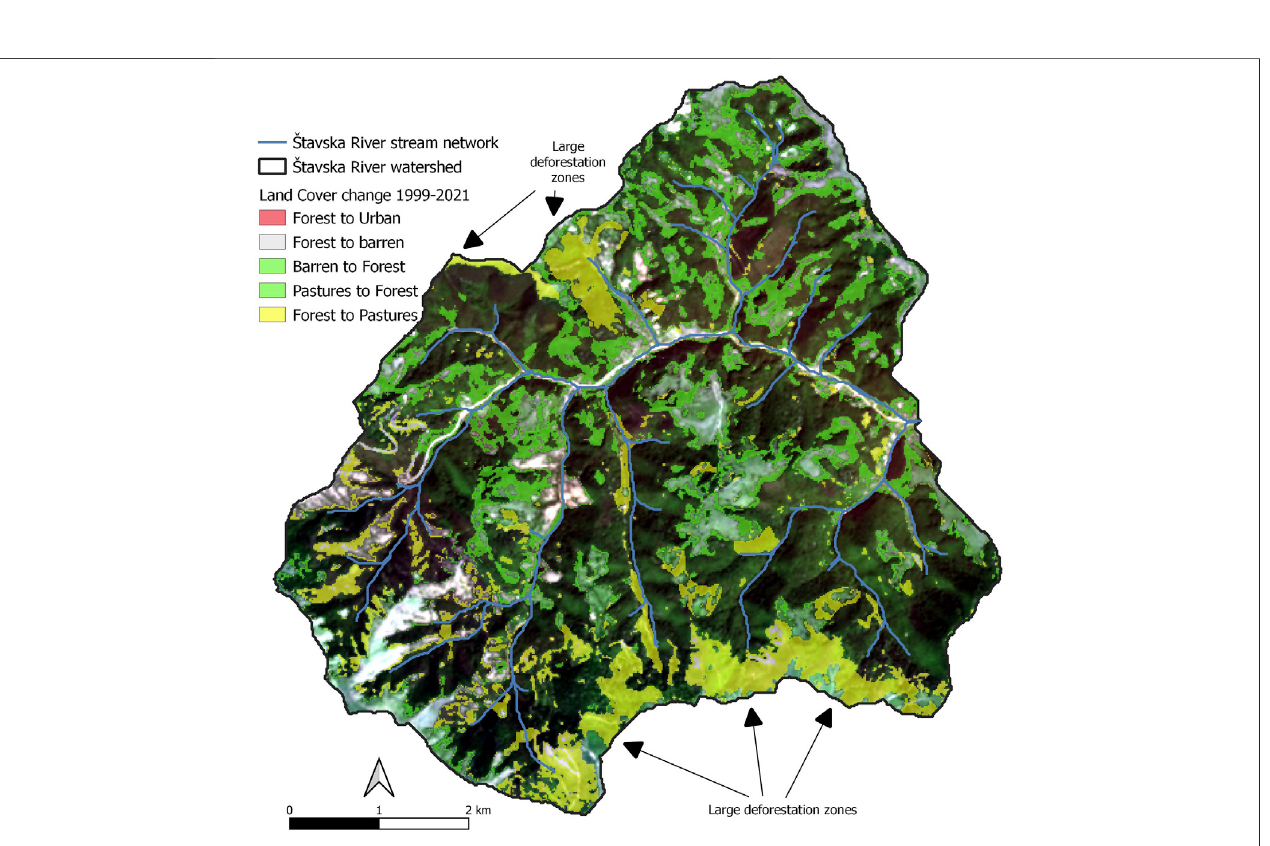
FIGURE 3 | Š tavska river watershed, selected change detection classes.